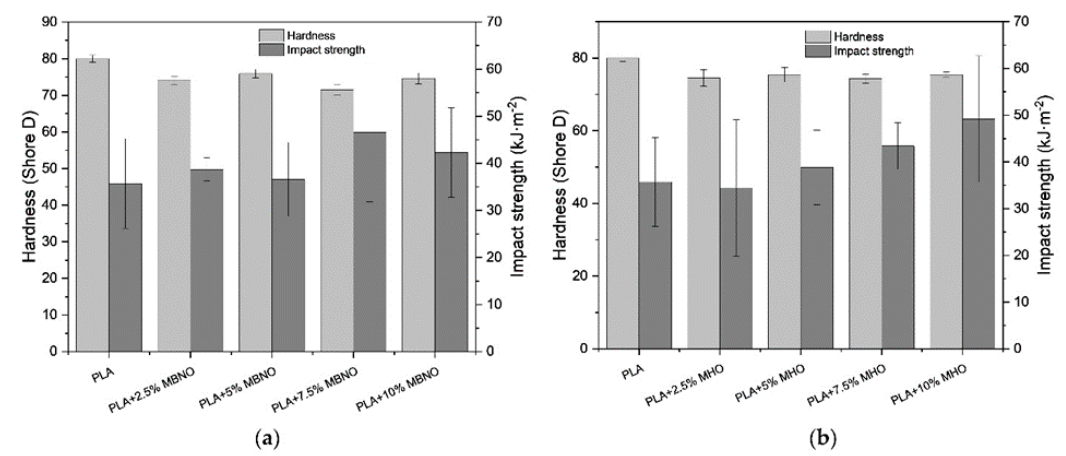
Figure 6. Plot of evolution of flexural properties of PLA formulations plasticized with various contents of MBNO ( a ) and MHO ( b ).